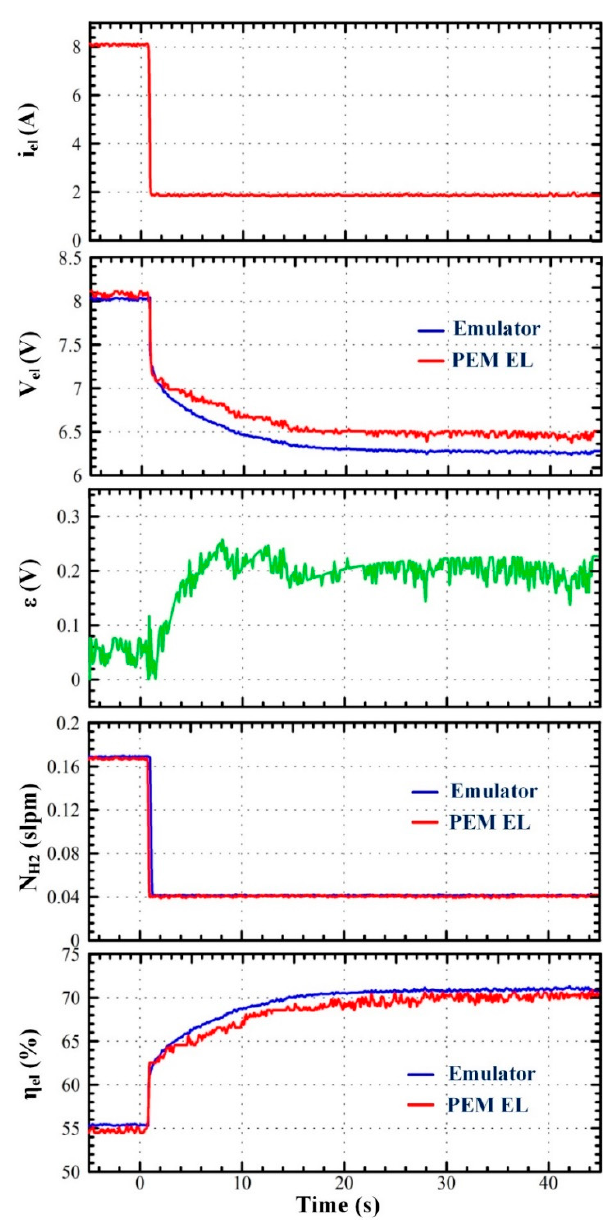
Figure 14. Comparison between the developed emulator and real electrolyzer for a step current drop from 8 down to 2 A.